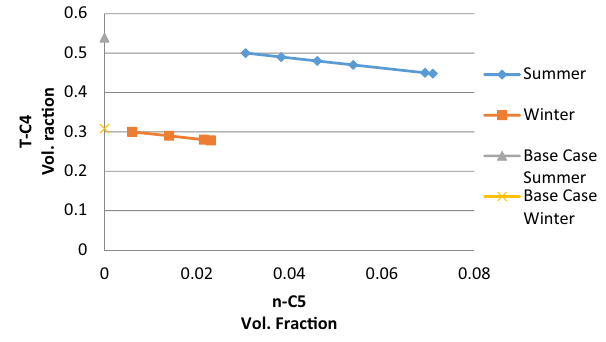
Fig. 25 Effect of adding n-C5 on LPG T-C4